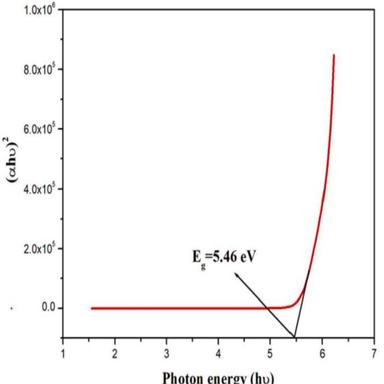
Band gap (Tauc's plot) of UGA crystal.